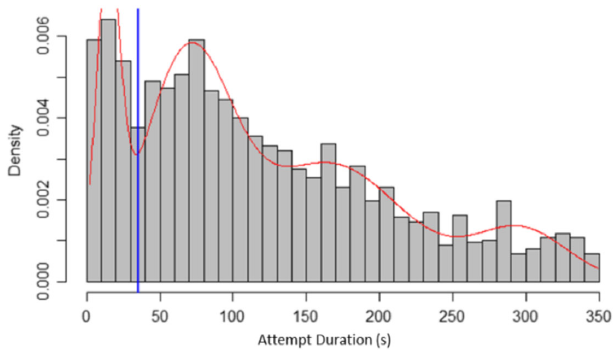
FIG. 2. Example of a mixture model fit of the duration histogram of 1st attempts on all 10 modules combined, with maximum duration of 350 sec. The blue line indicating the 35 sec cutoff used in the current